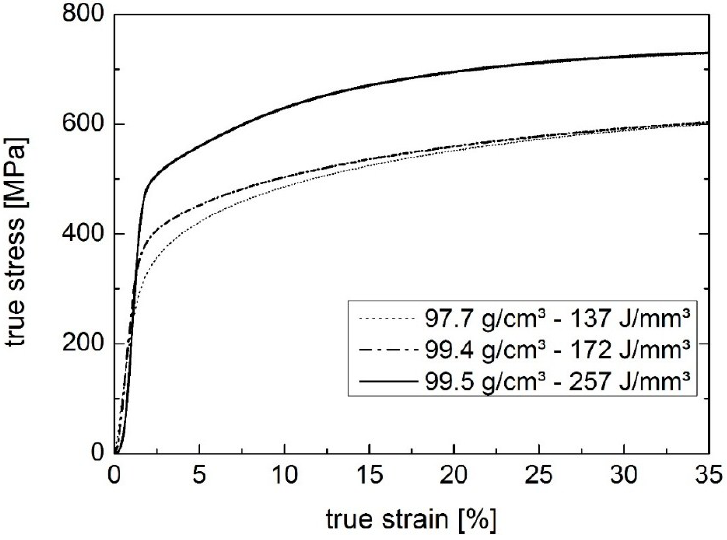
Figure 6. Compression test curves of the samples produced by SLM with different energy